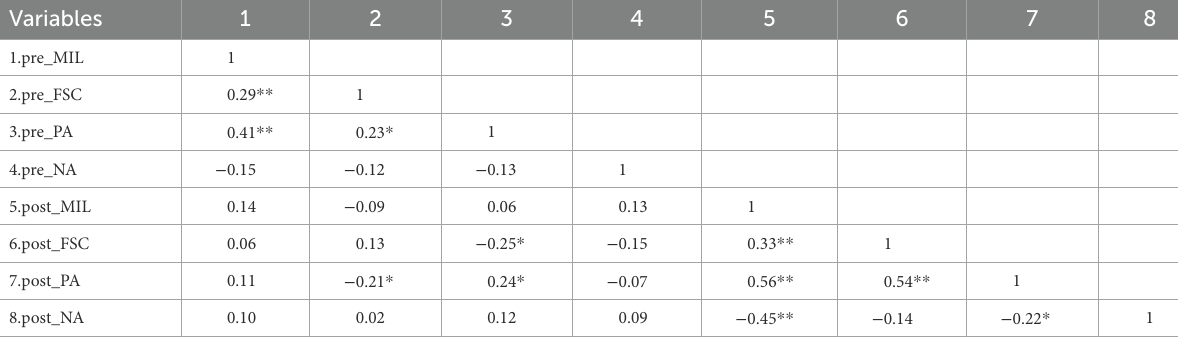
TABLE 3 Correlations among the variables at pre-test and post-test. Variables